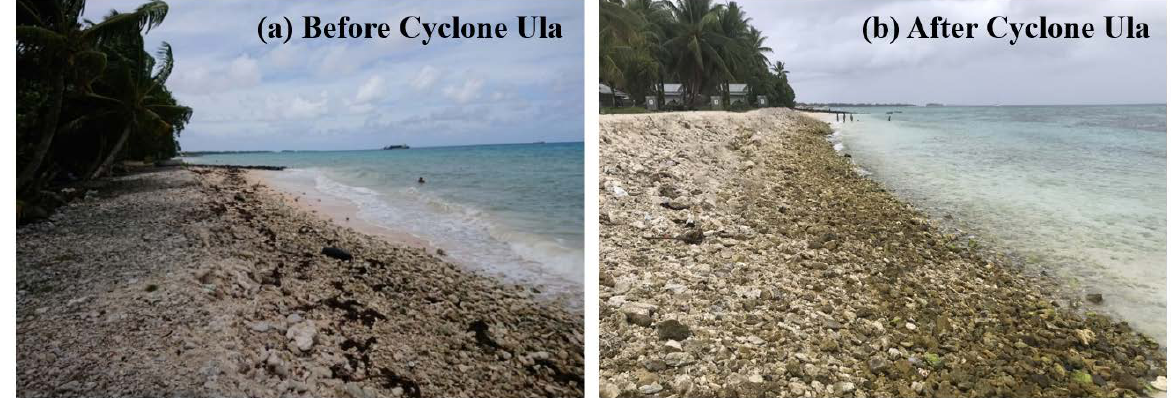
Figure 8. Southern part of Catalina Ramp with gravel